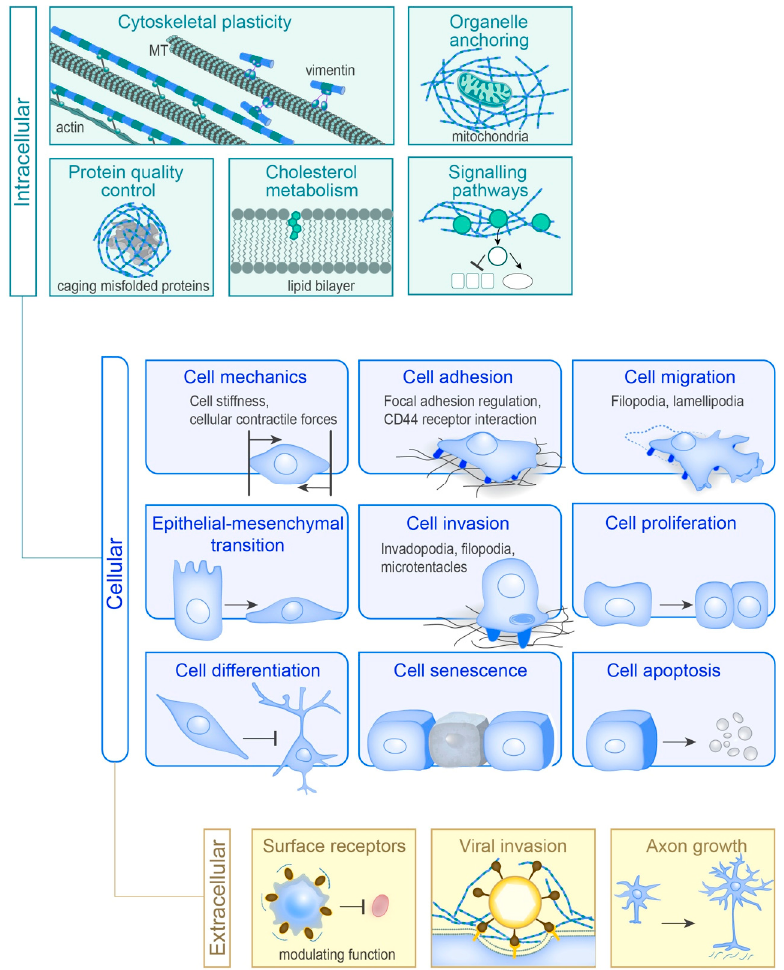
Figure 3. Examples of how the vimentin protein control cells, on a molecular ( top ), cellular ( middle ) and extracellular ( bottom ) level.